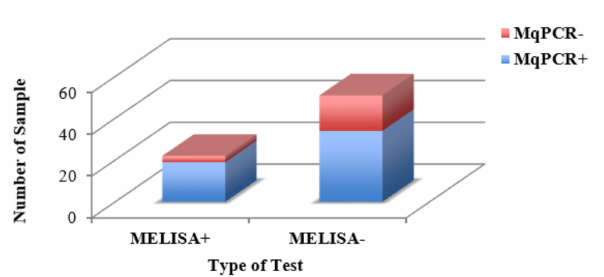
Figure 8. The distribution of 73 BTM samples classified into four binary groups based on the positive / negative status in the MqPCR and MELISA tests. Pos (MqPCR) and Neg (MELISA) constituted the main proportion of samples (46.58%), followed by 26.03% Pos (MqPCR and MELISA), 23.3% Neg (MqPCR and MELISA), and 4.11% Neg (MqPCR) and Pos (MELISA). Pos: positive; Neg: